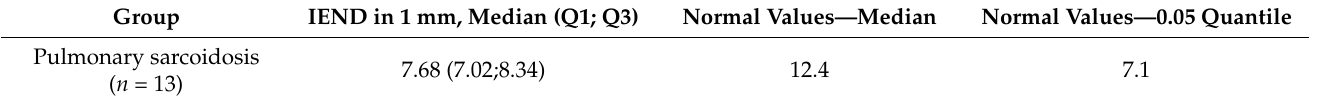
Figure 2. Skin biopsy of patient with sarcoidosis (enzyme immunoassay, male, 34 years). A total of 13 of the biopsies were obtained from patients with sarcoidosis (Table 4). The calculations of the intraepidermal density of the small fibers were performed in accordance with the values obtained from the worldwide normative reference study [23]. Table 4. Intraepidermal nerve fiber density (IEND) in patients with sarcoidosis. Group